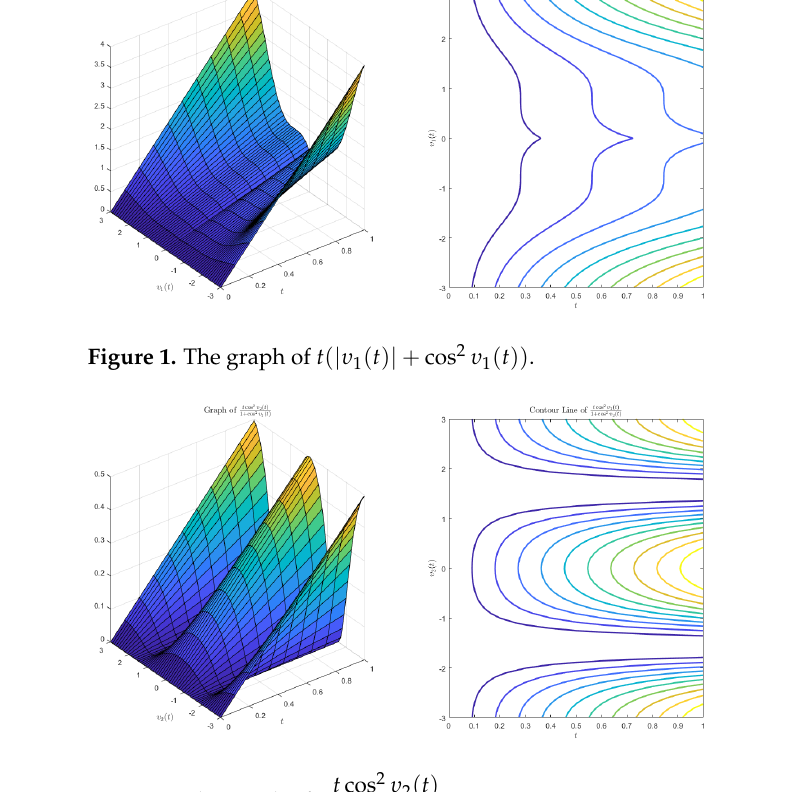
Figure 2. The graph of